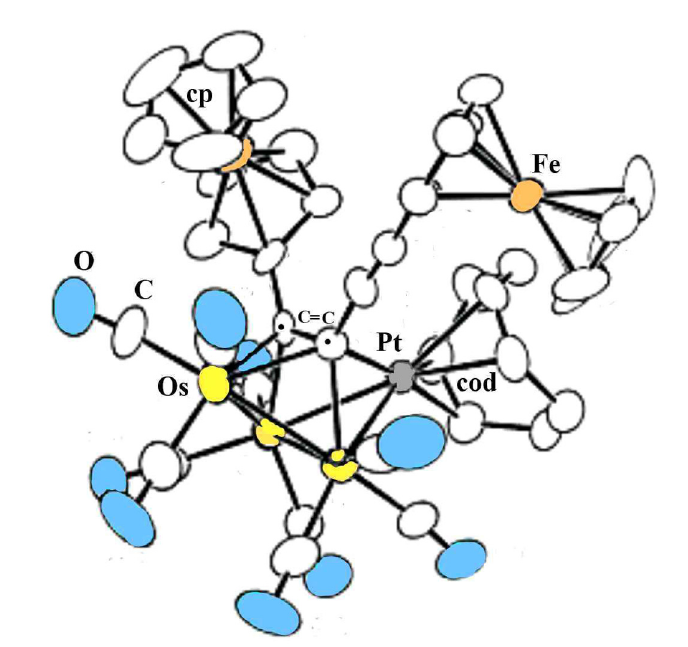
(CO) (µ-cpbcp)Fe (cp) ] [72]. 3 9 2 2